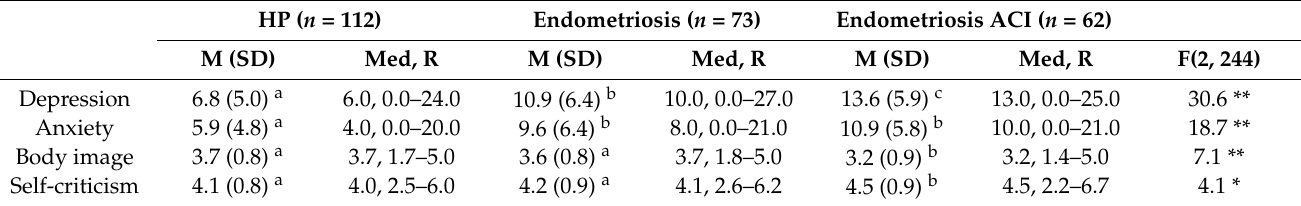
Table 1. Group comparison.